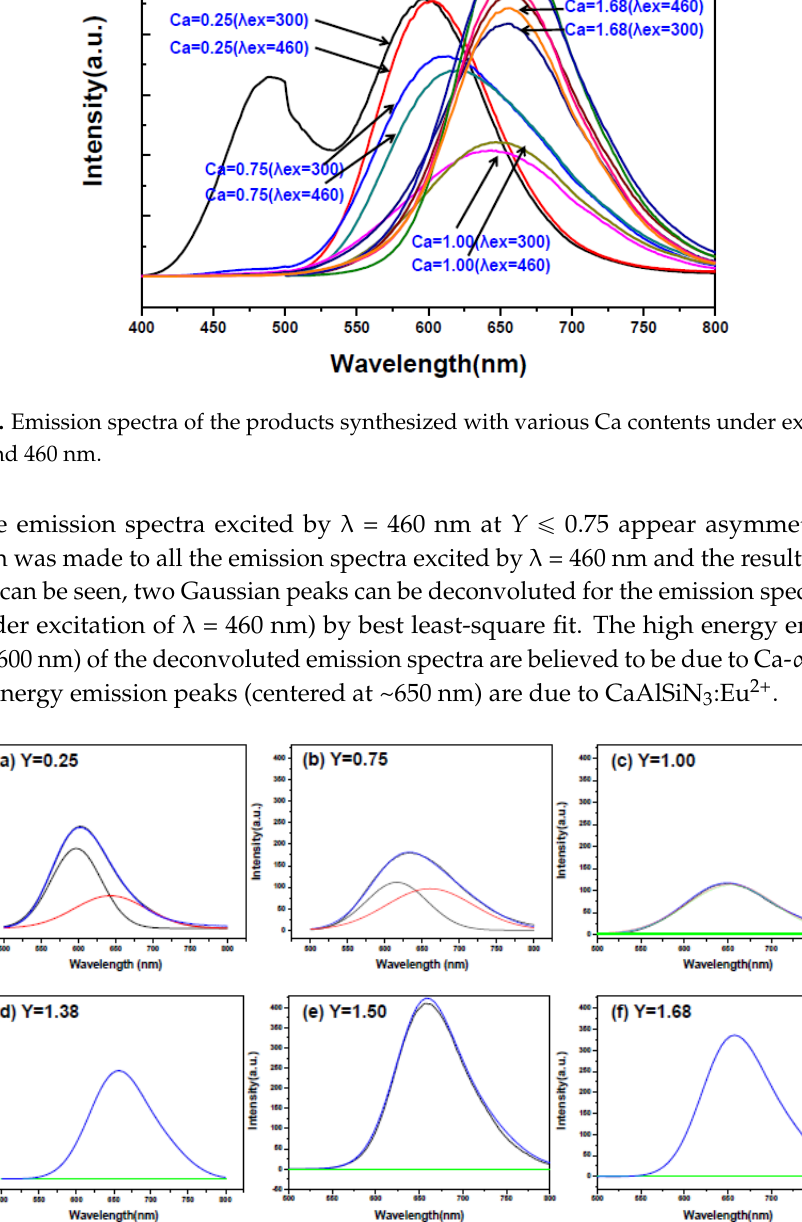
Figure 12. Gaussian deconvolution of photoluminescence emission spectra (by excitation of λ = 460 nm) of the products synthesized with various Ca contents.